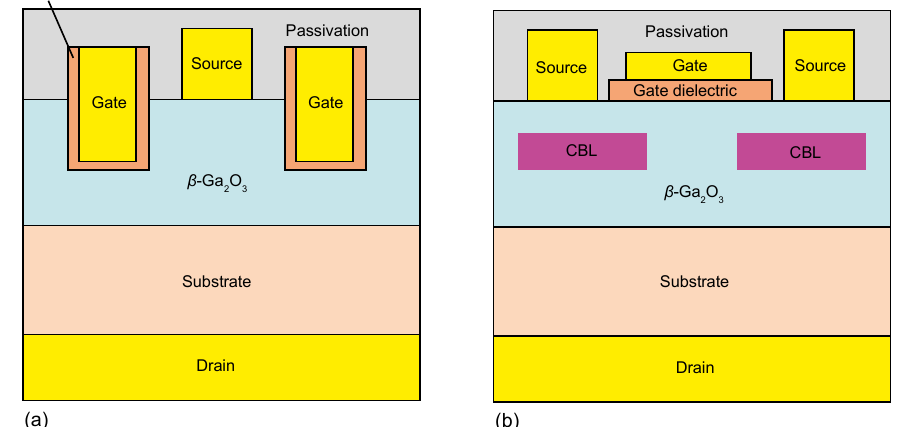
Figure 14. ( a ) Depletion ‐ mode vertical β ‐ Ga 2 O 3 trench MOSFET. ( b ) Planar ‐ gate current aperture vertical β ‐ Ga 2 O 3 MOSFET.